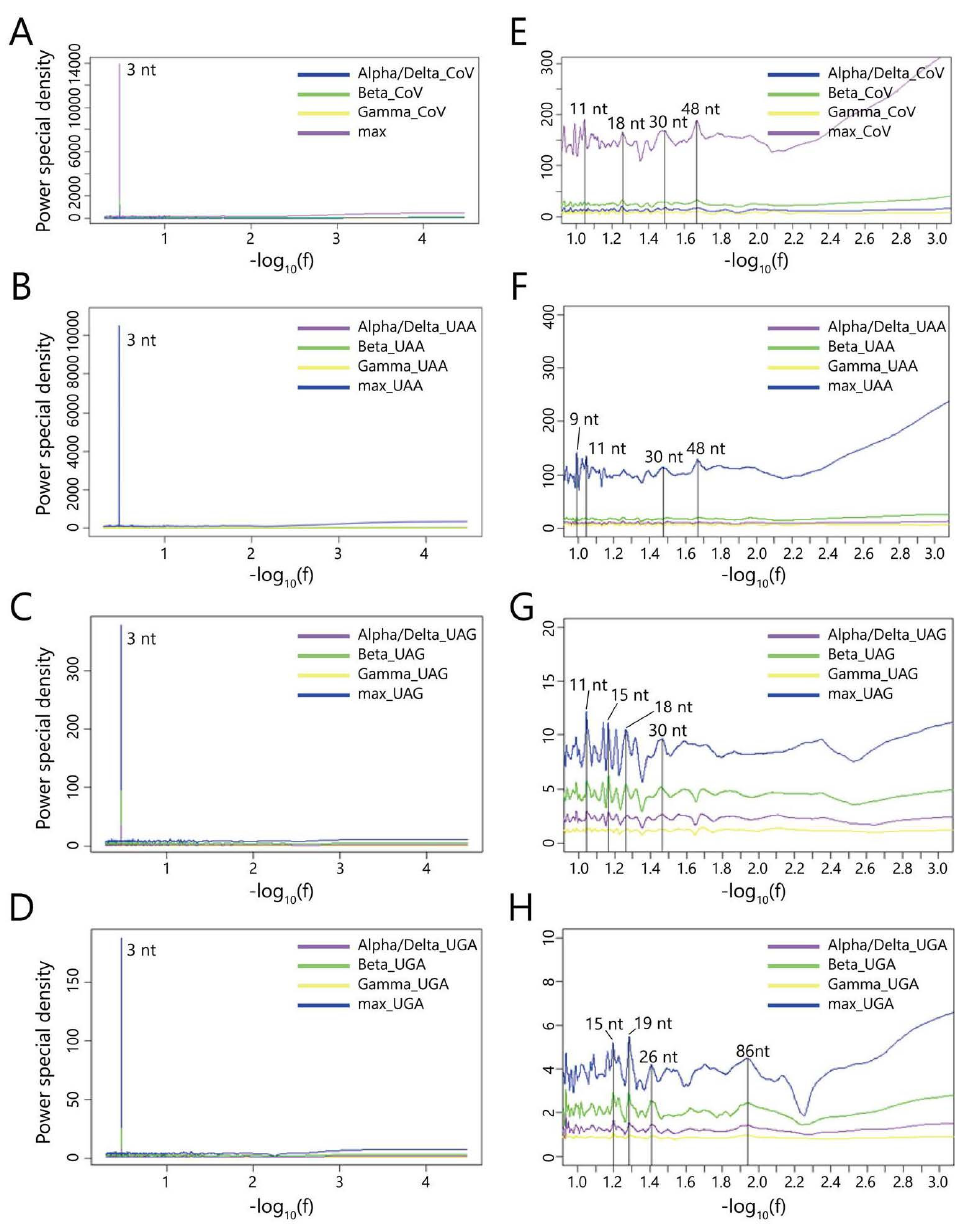
Figure 8. Implementation of sequence periodicity analysis using power spectrum. ( A ) Overall power spectrum of all kinds of stop codons (UAA, UAG and UGA); ( B ) Overall power spectrum of the stop codon UAA; ( C ) Overall power spectrum of the stop codon UAG; ( D ) Overall power spectrum of the stop codon UGA. Since 3 nt frequency peaks in the overall power spectrum (represent stop codons, ( A – D ) are obvious, we zoom in each figure to investigate other periodic patterns except for 3 nt by ( E – H ). The horizontal axis ( − log (cid:2869)(cid:2868) 𝑓 ) ) represents the length of periodic sequences (f) and the vertical axis represents the power density of corresponding spectrum. Purple, green, and yellow lines of each stop codon represent the power spectrum when the maximum number of stop codons during mutation (Method S3) starts to deviate from the base content percentage of Alpha-CoV/Delta-CoV, Beta-CoV and Gamma-CoV, respectively. Table 1. Periodicity of the distribution of three stop codons .